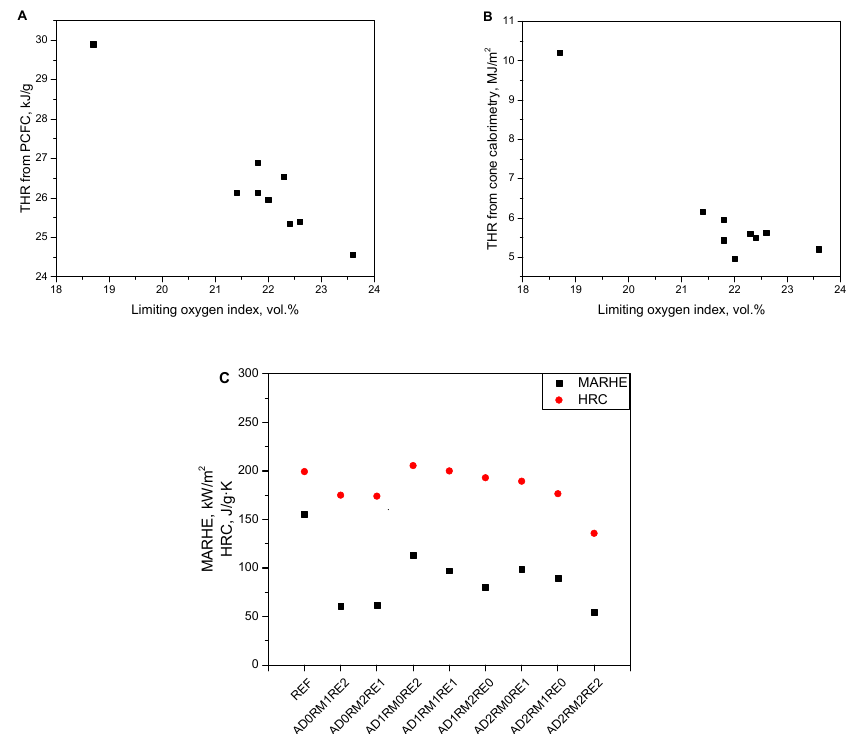
Figure 9. Correlation between the limiting oxygen index and THR from PCFC ( A ), limiting oxygen index and THR from cone calorimetry ( B ) as well as MARHR and HRC ( C ).